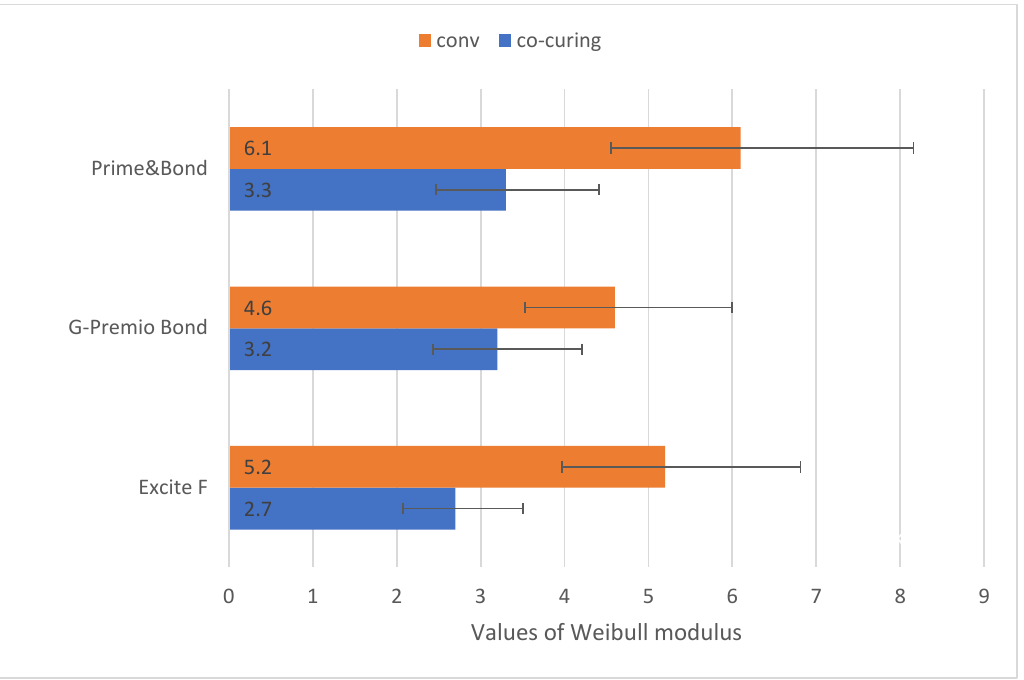
Figure 3. Weibull modulus. Note: Error bars represent 95% confidence intervals. Weibull diagrams in Figure 4 show that conventional application of adhesive shifted the Weibull distributions towards higher values on the x-axis, reflecting the increase in the scale parameter, while the steeper slope of the fit lines reflects a higher consistency and less scattering of strength values. The mean strength ( Pf = 50%) and characteristic strength ( Pf ≈ 63.2%) followed a similar variation pattern across all experimental groups (Figure 5). The bond strength between the occlusal parts of the tooth (mean = 17.1 MPa) and the radicular parts of the tooth (mean = 15.3 MPa) was statistically significantly different ( p = 0.007).